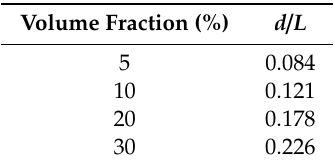
Table 1. Design data of multiple BCC xyz lattices.